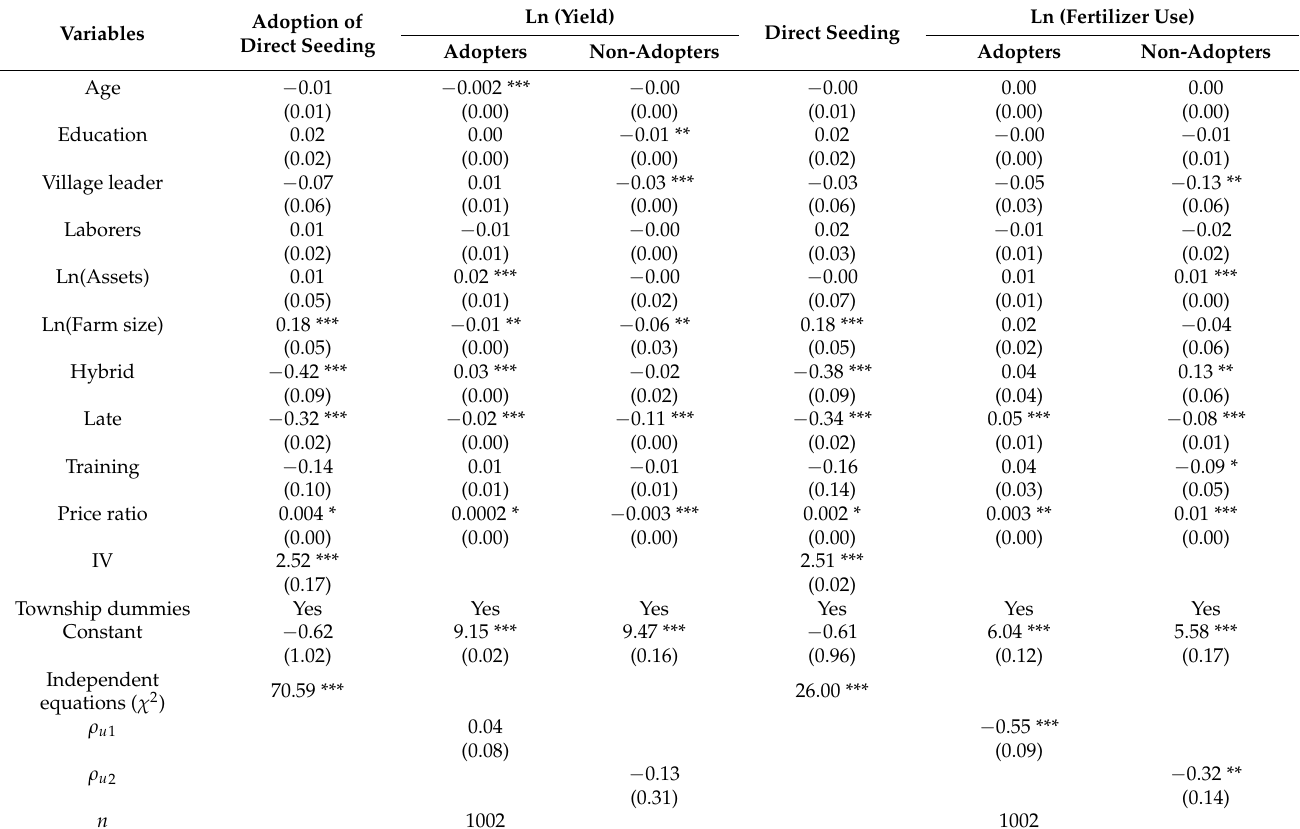
Table 3. Estimated results of the effects on the yield and fertilizer use in rice